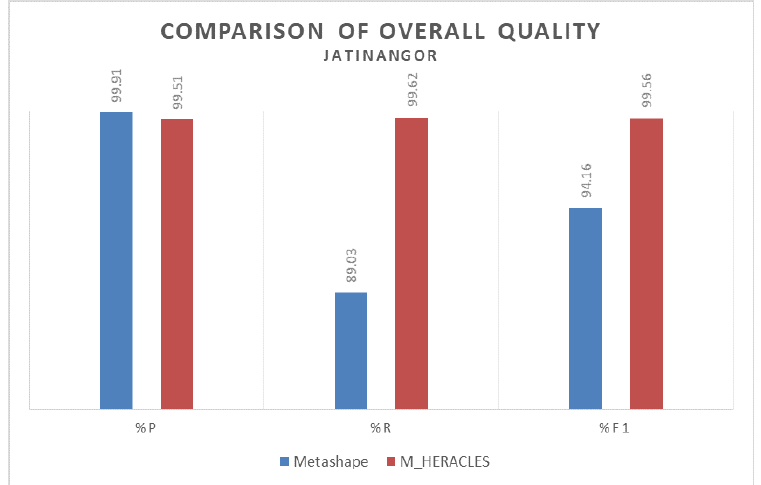
Figure 6. Global comparison of the precision, recall, and F1 scores of the classification results from M_HERACLES and